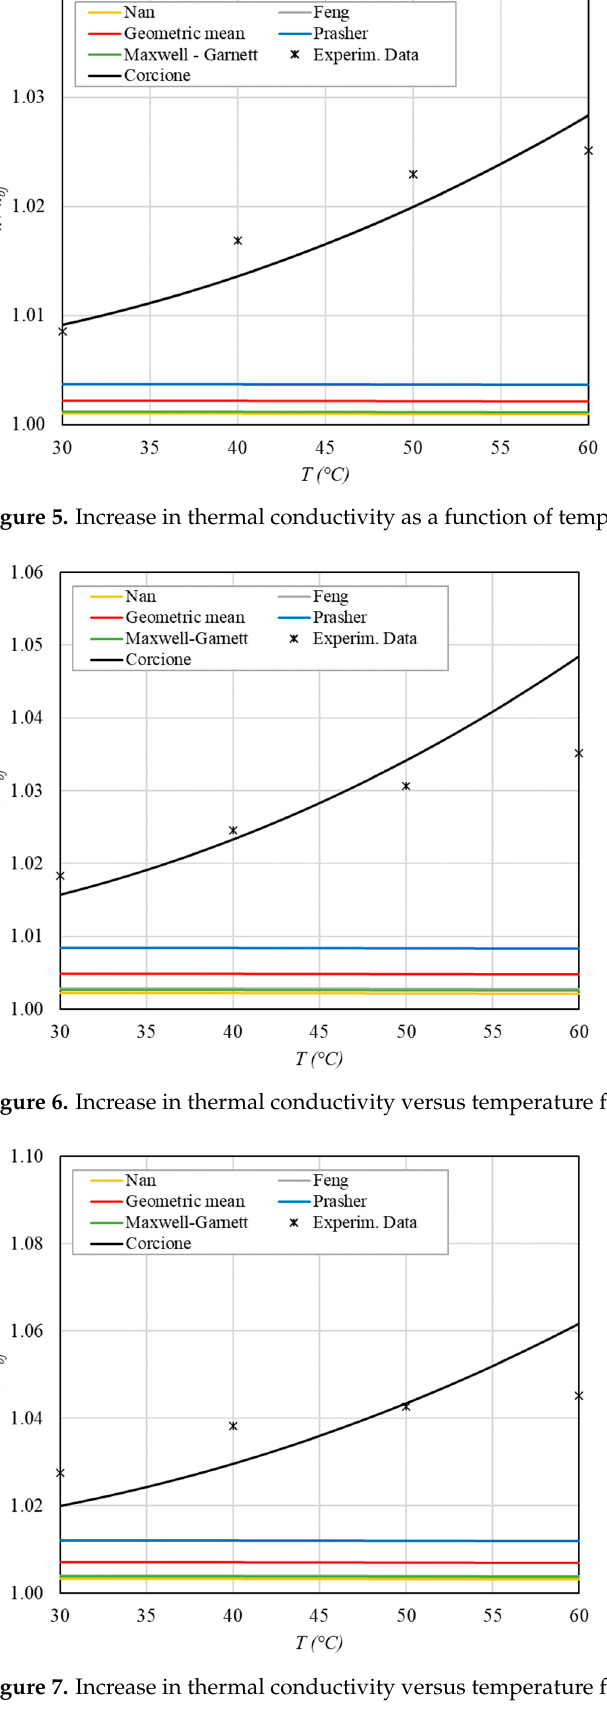
Figure 8. Increase in thermal conductivity versus temperature for φ = 0.17% .